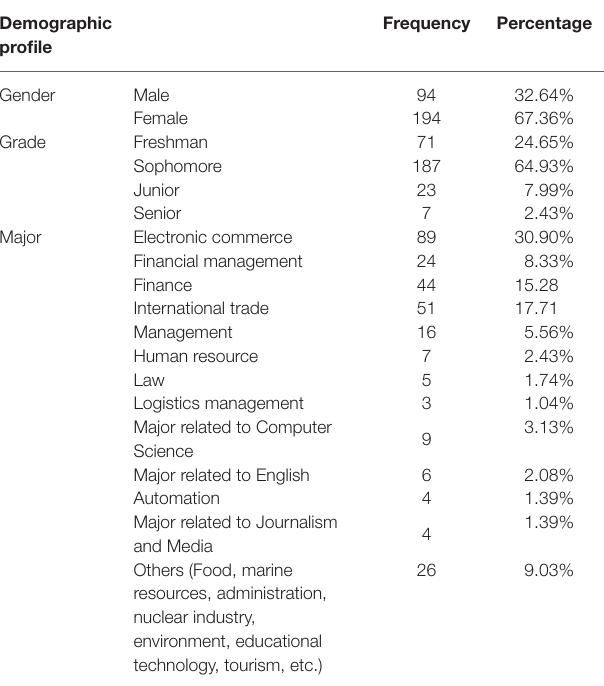
TABLE 2 | Indicators for